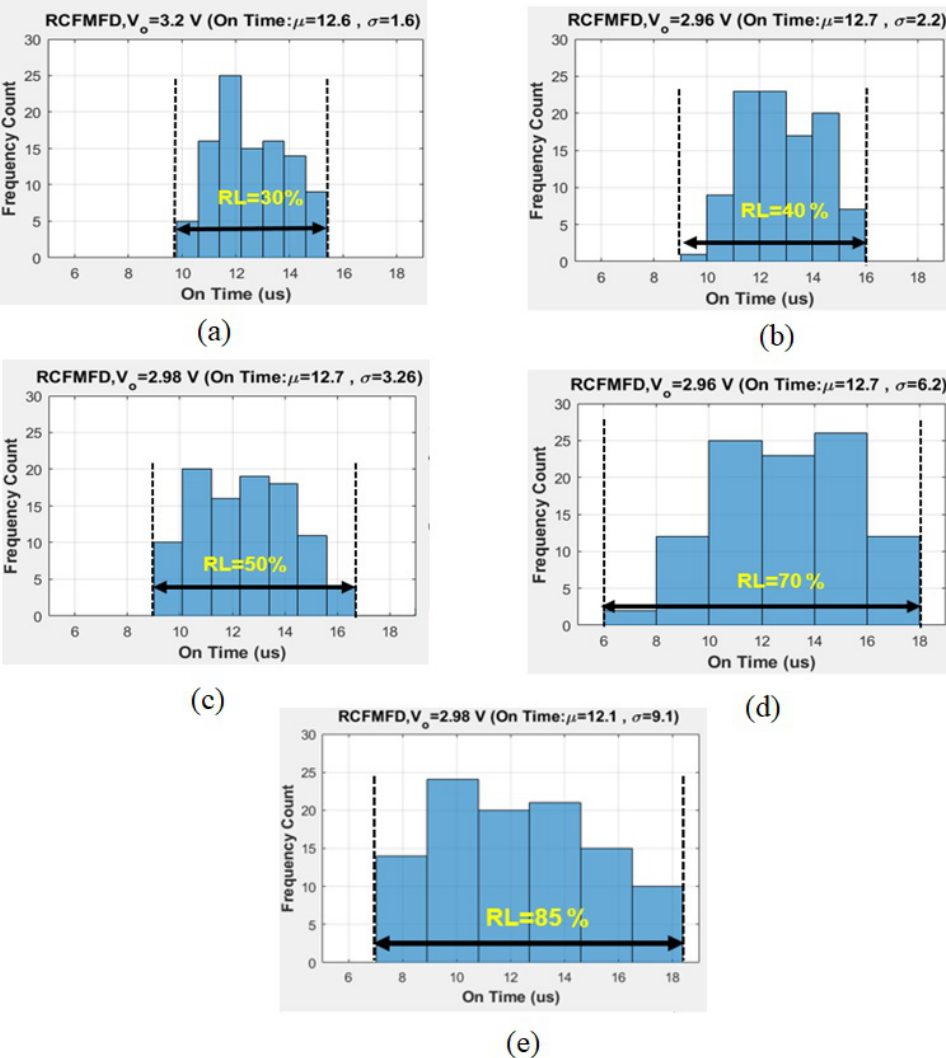
Figure 18. Comparison of the histograms of the switch 1 switching signal for various randomness levels (RL) of RCFMFD for an interleaved converter ( a ) 30% RL, ( b ) 40% RL, ( c ) 50% RL, ( d ) 70% RL, and ( e ) 85%